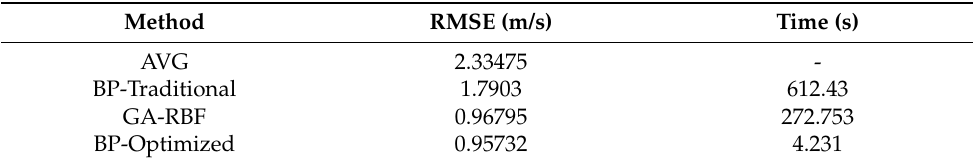
Table 3. Precision and computation times of various models.